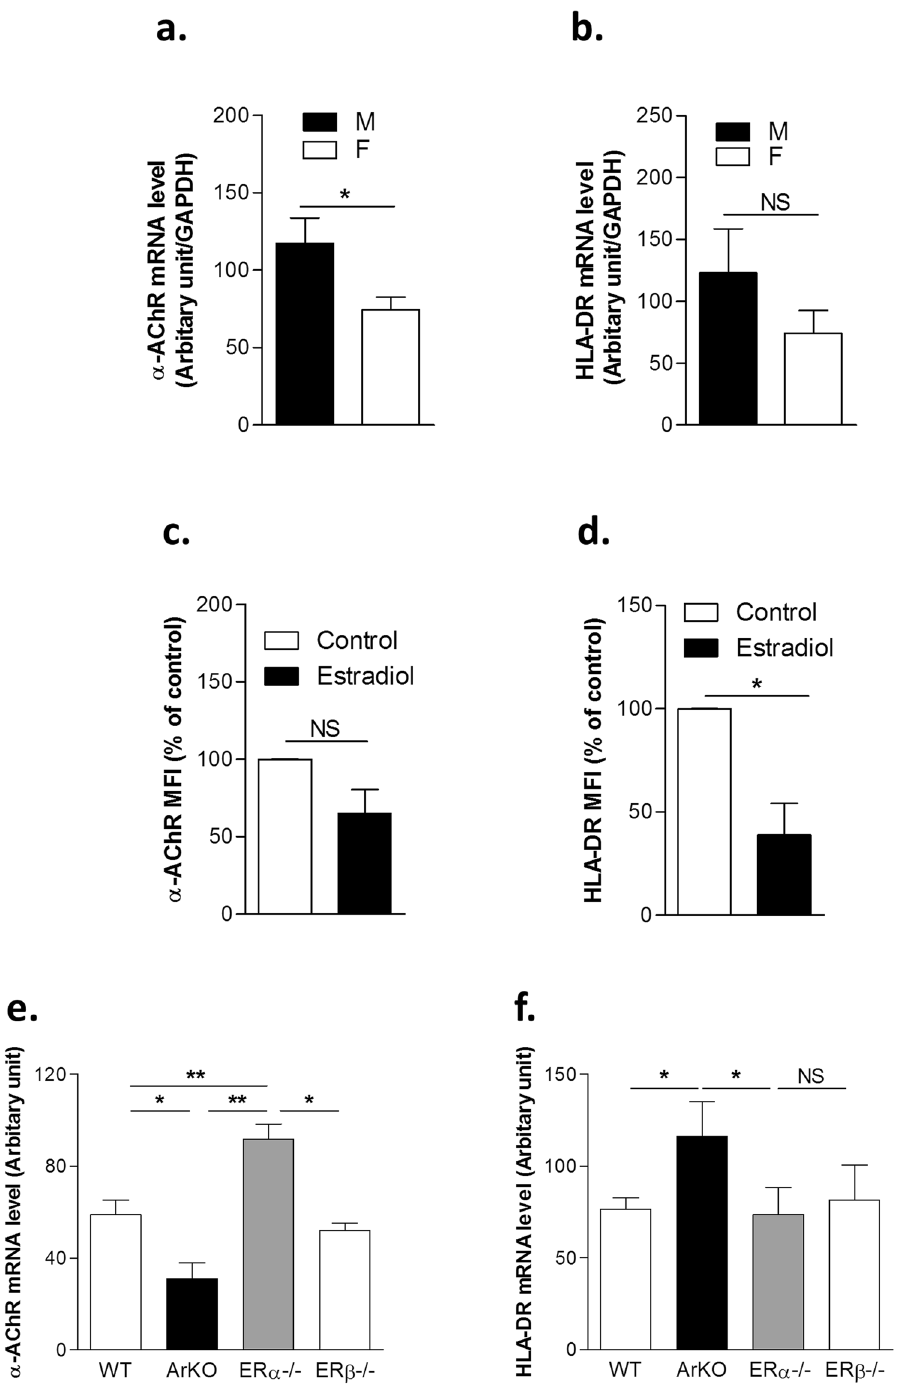
Figure 1. Modulation of α -AChR and HLA-DR expression in human and mouse thymuses and by β -estradiol in human primary cultured TECs. mRNA expression levels of α -AChR ( a ) and HLA-DR ( b ) in normal human male and female thymuses. Effect of 17- β estradiol (10 − 8 M) on α -AChR ( c ) and HLA-DR ( d ) protein expression in human primary TECs. mRNA expression levels of α -AChR ( e ) and MHC II ( f ) in thymuses of C57Bl6J, Aromatase knock-out (ArKO), estrogen receptor α KO (ER α− / − ) and estrogen receptor β KO (ER β− / − ) female mice. (n > 4 for human and n > 3 for mouse thymuses). P values were obtained using Mann-Whitney test for ( a , b ); P values were obtained using the Wilcoxon test for ( c , d ); P values were obtained using the Student t test for ( e , f